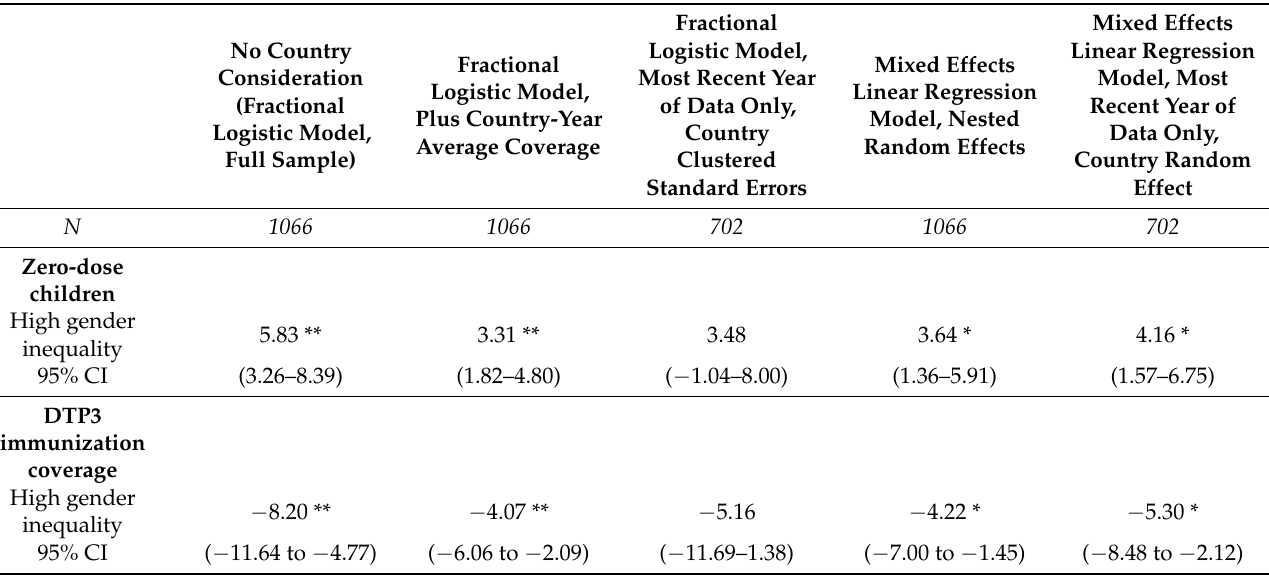
Table 4. Predicted marginal effects [percentage point difference] for zero-dose DTP prevalence and DTP3 immunization coverage by SGDI category (702 subnational regions across 57 countries,